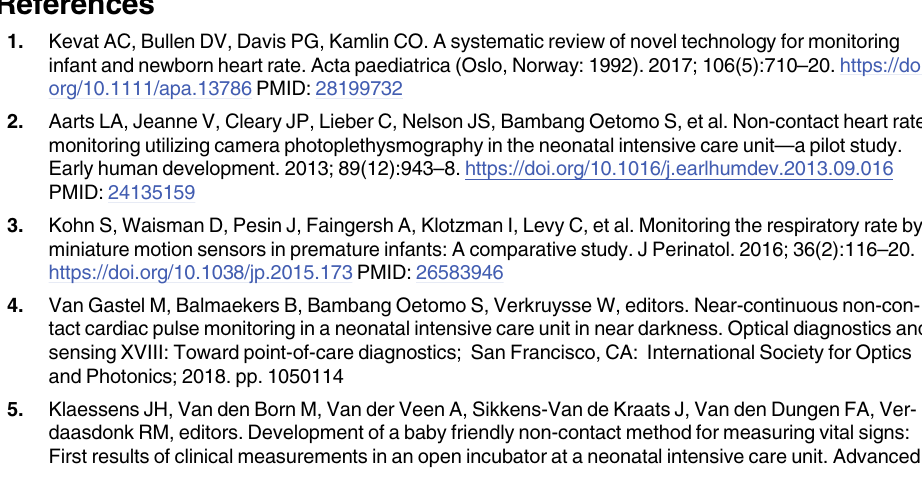
difference and the lower and upper limits of agreement by Bland-Altman plota are indicated